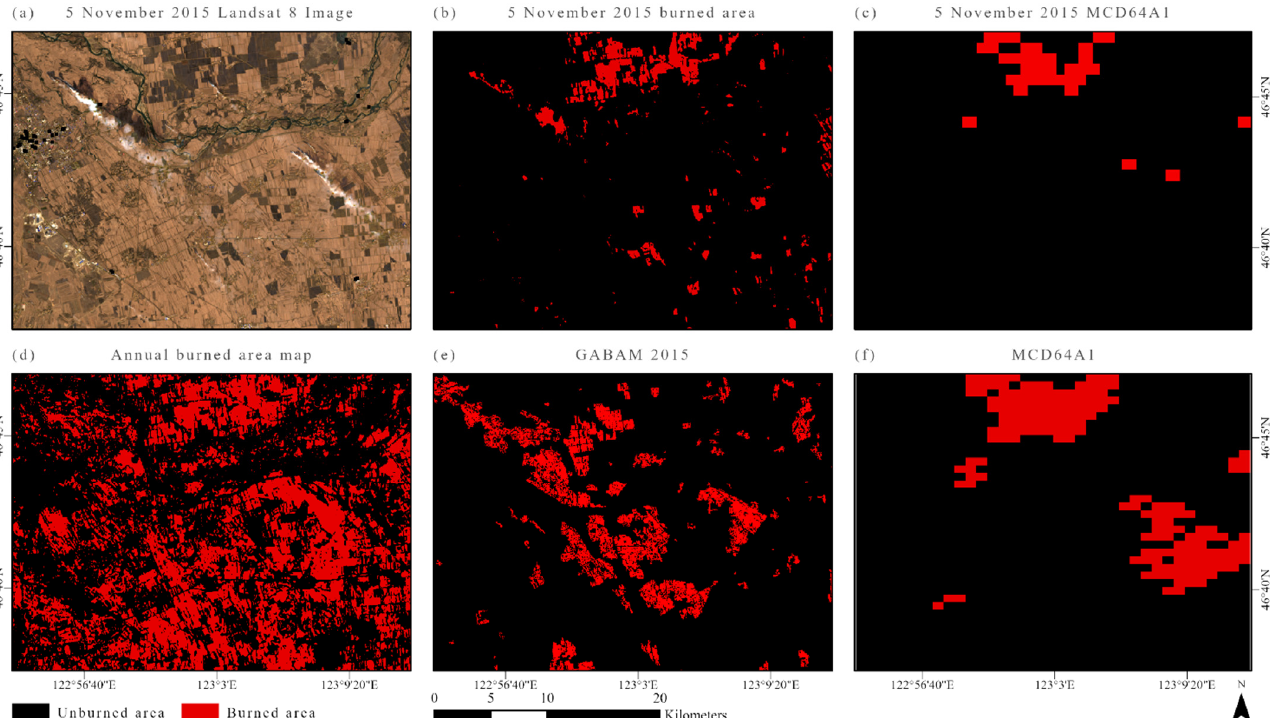
Figure 9. Comparison of different cropland burned area maps for the year 2015: ( a – c ) true-color composite Landsat 8 images acquired on 5 November 2015, and cropland burned area maps based on Landsat 8 images with our algorithm and MCD64A1 product on the same day. Panels ( d – f ) show derived annual cropland burned area maps with our algorithm, GABAM 2015 product, and MCD64A1 product, respectively. The derived annual cropland burned area map and the GABAM 2015 map have a 30 m spatial resolution while the MCD64A1 product has a 500 m spatial resolution.